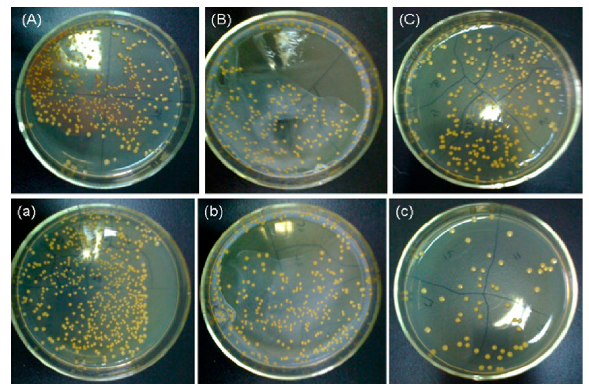
Figure 25. Photographs of E. coli colonies developed on agar plates treated with ( A ) control, ( B ) TiO 2